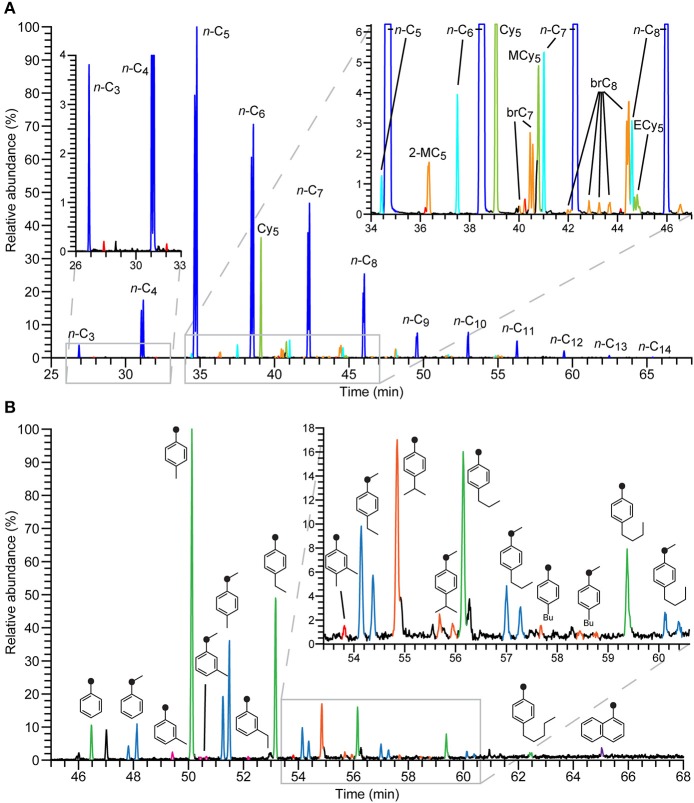
Partial ion chromatograms (upper trace, m/z 114; lower trace, m/z 226+236 + 250+264+278+292+306) of a methylated extract of strain TD3 after anaerobic growth with crude oil. Annotated peaks represent alkyl-/arylalkyl-succinates formed from respective hydrocarbon precursors. (A) Homologous series of activation products of n-alkanes in blue, branched alkanes in orange and cycloalkanes in green. The red series indicates n-alkylsuccinates not directly derived from n-alkanes (Annotation code: n-Cx, n-alkanes; 2-MC5, 2-methylpentane; brCx, branched alkanes; Cy5, cyclopentane; MCy5, methylcyclopentane; ECy5, ethylcyclopentane). (B) Succinates derived from aromatic hydrocarbons as indicated by their structures. Their respective activation positions are highlighted by black dots. (green, homologous series derived from p-n-alkyltoluenes; blue, homologous series derived from p-n-alkylethylbenzenes; magenta, succinates derived from m-dialkylbenzenes; orange, succinates derived from p-dialkylbenzenes with one branched side chain).